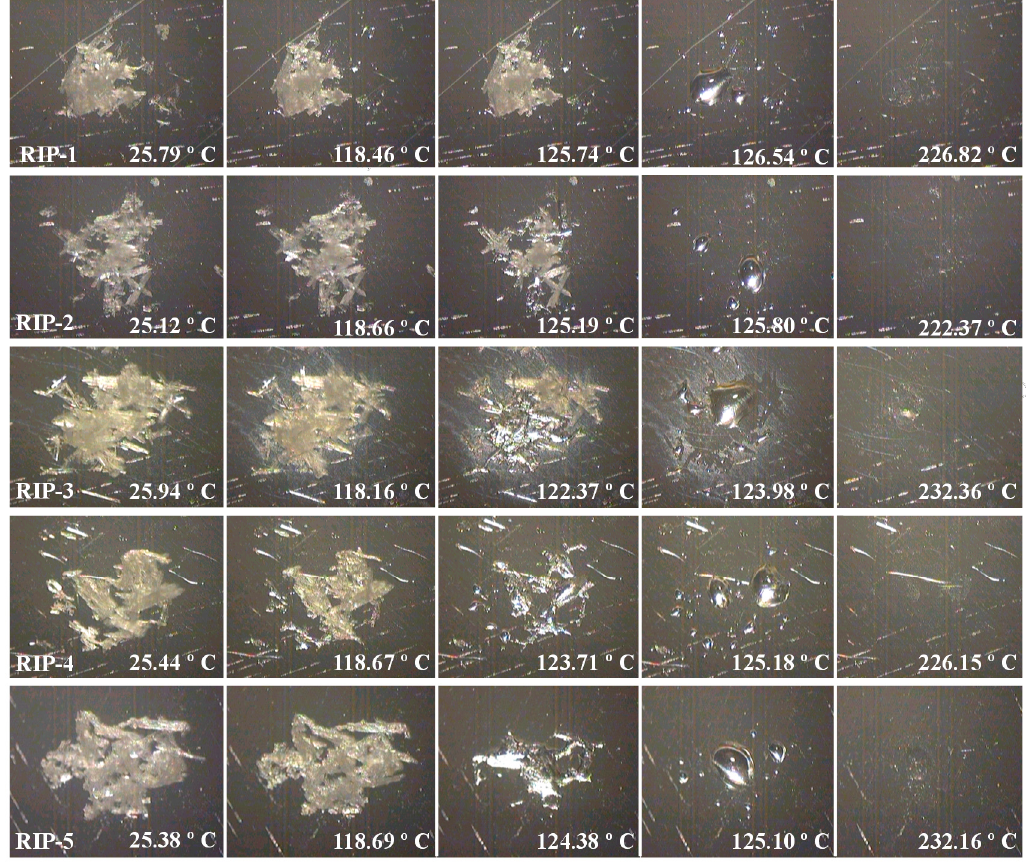
Figure 3. DSC-Photovisual of RIP-1, RIP-2, RIP-3, RIP-4, and RIP-5 samples in the heating 400 rate of 10 °C·min − 1 .